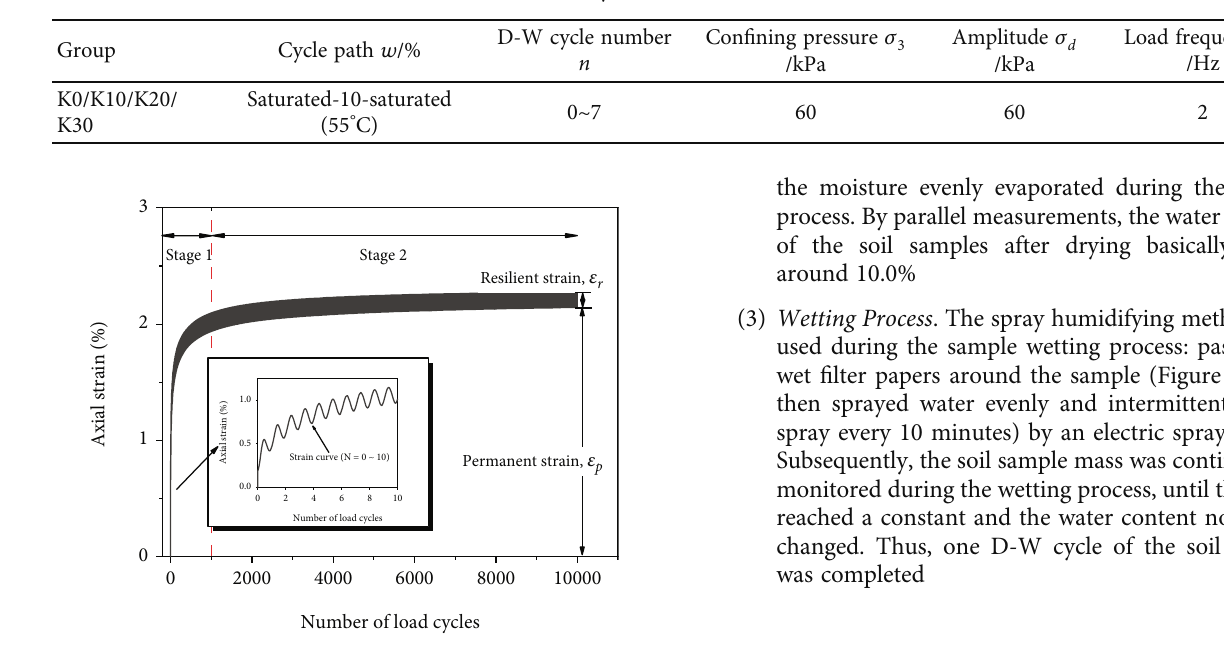
Figure 8: Strain curve of GRS under train vibration